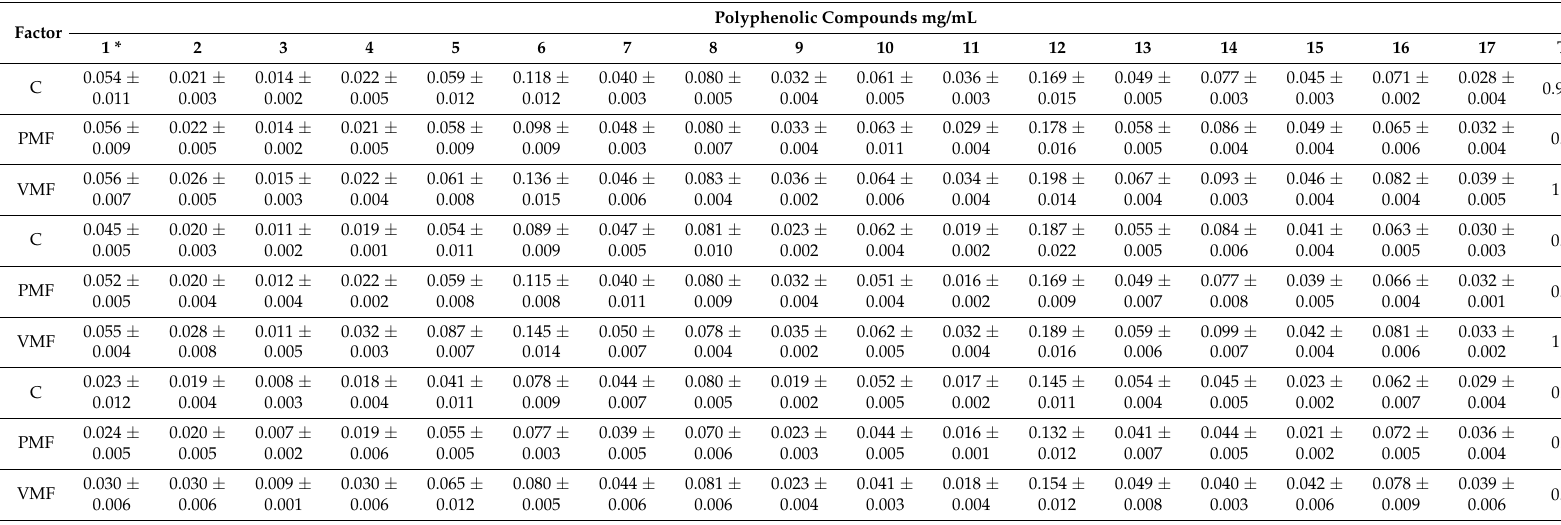
Table 5. Analytical findings showing contents of selected polyphenolic compounds in black tea infusions extracted with the use of a magnetic field under control